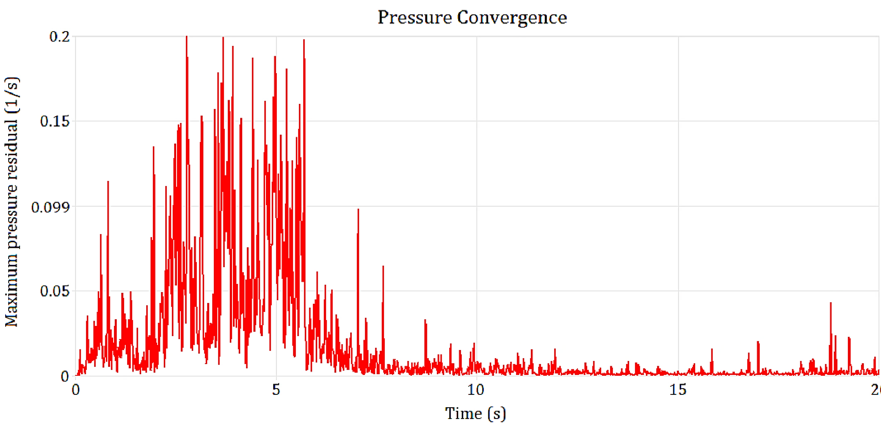
Figure 21. The convergence of the numerical modeling solution.